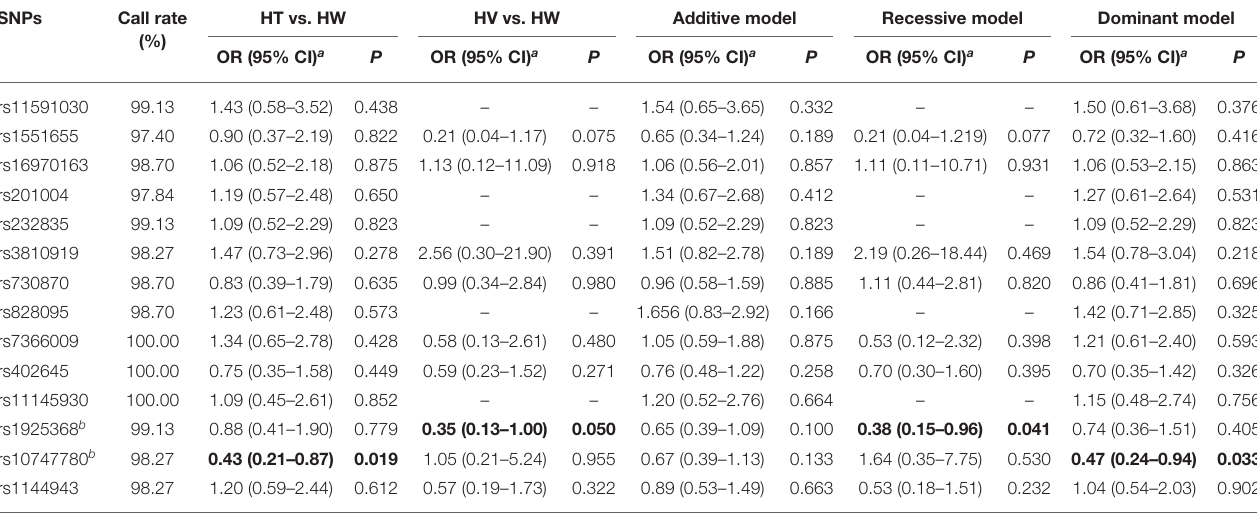
TABLE 2 | Association of candidate variants with therapeutic effect of neoadjuvant chemotherapy in the discovery stage. SNPs